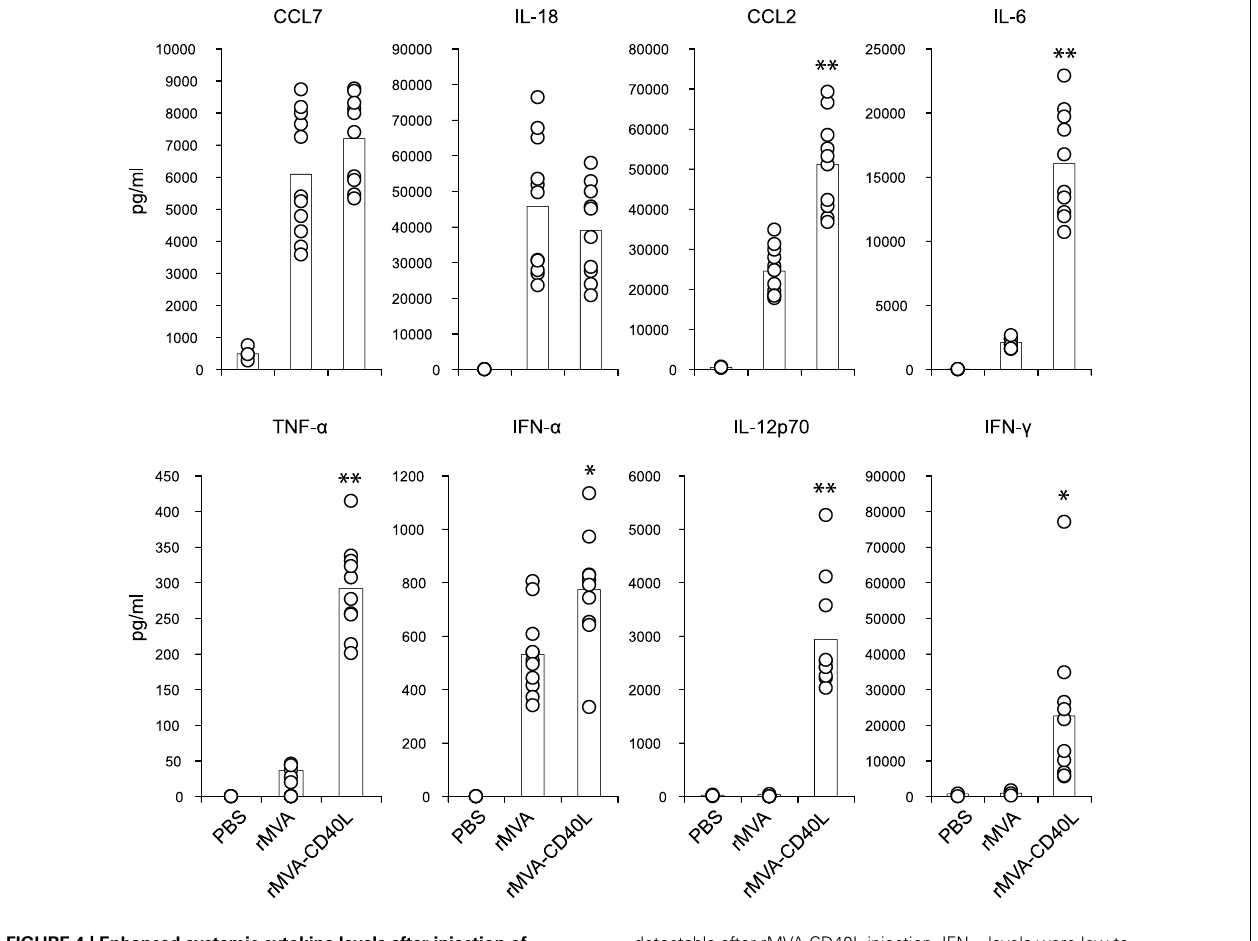
detectable after rMVA-CD40L injection. IFN- γ levels were low to undetectable after rMVA immunization. Results are compiled from three independent experiments. Circles denote individual mice and bars the mean of all mice per group.